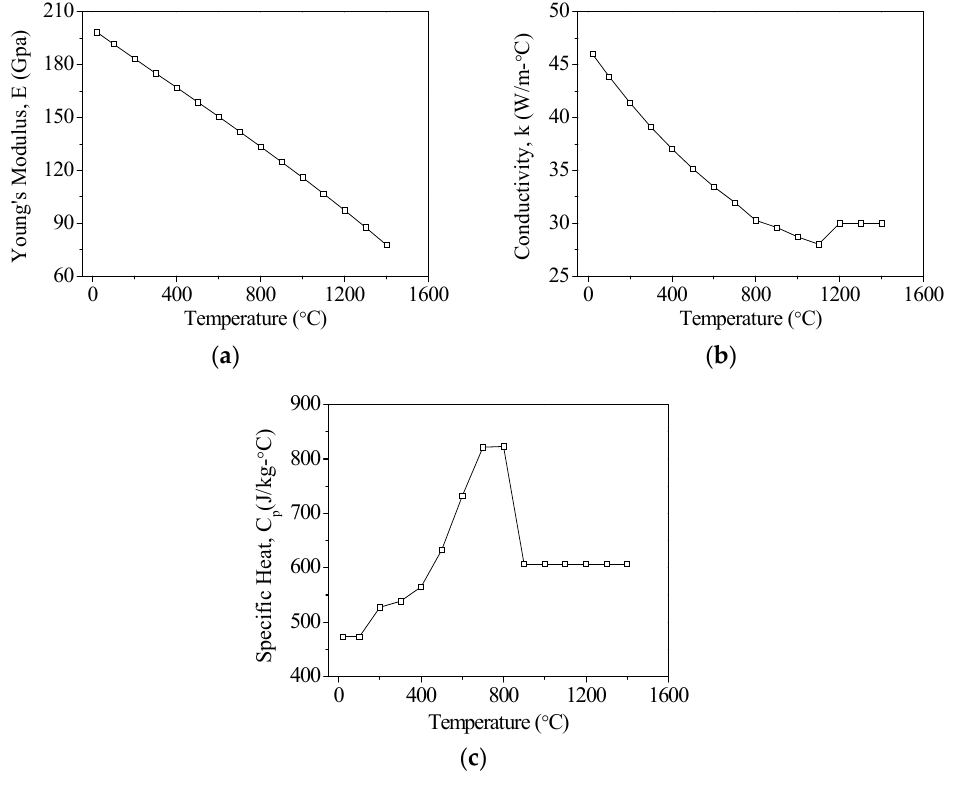
Figure 2. The temperature depenent material properties of AISI 1045. ( a ) Young’s modulus; ( b ) Coefficient of thermal conductivity; and ( c ) Specific heat.